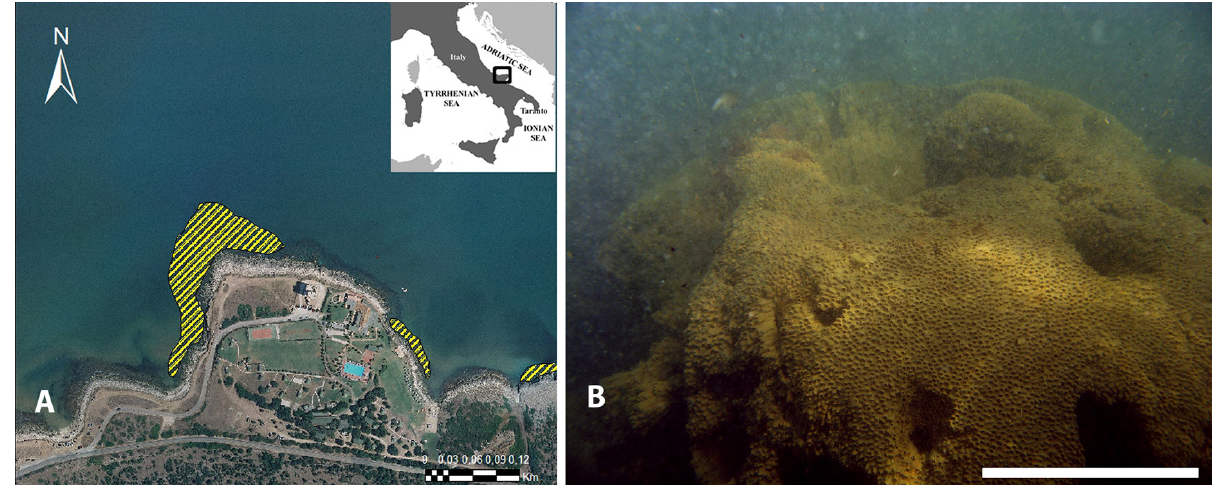
Fig. 1. – Sabellaria spinulosa sampling site at Torre Mileto (Gargano, southern Adriatic Sea). A, map of the study site; B, underwater photo from a reef; scale bar 60